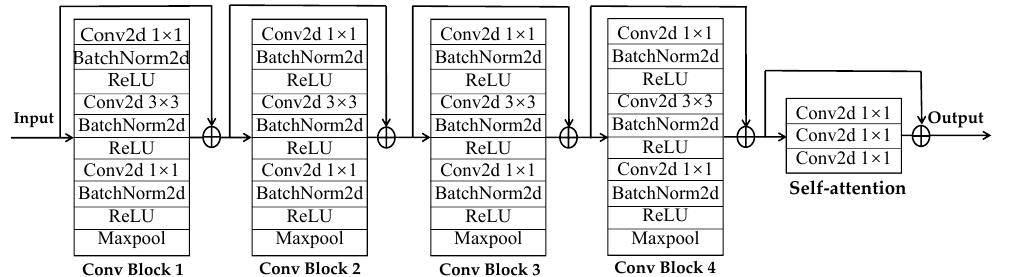
Figure 5. Structure and parameters of the feature encoder.